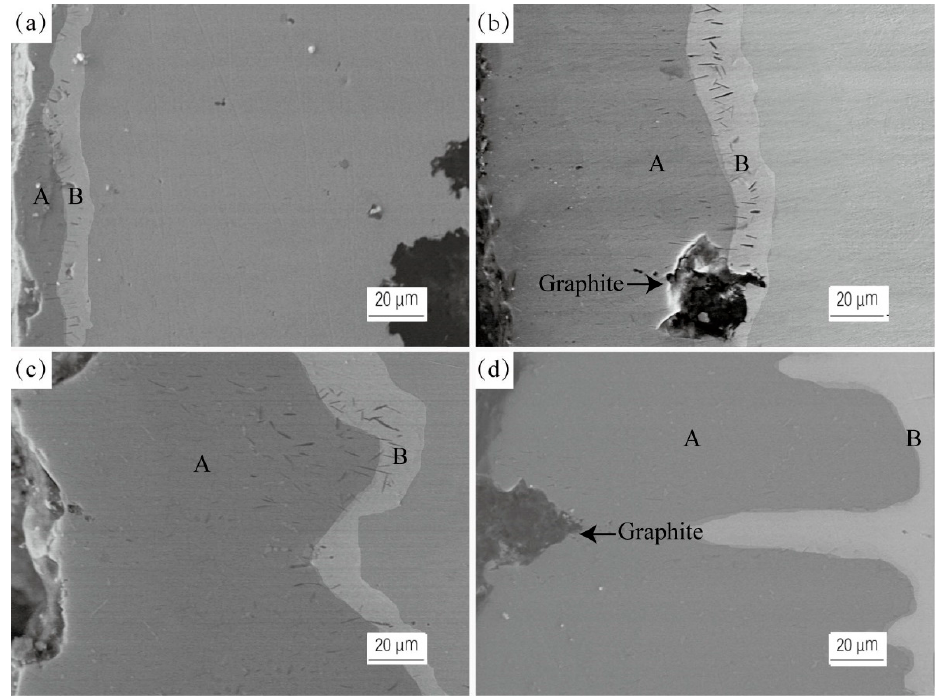
Figure 3. The cross-sectional microstructures of aluminizing samples at ( a ) 800 °C; ( b ) 830 °C; ( c ) 850 °C; ( d ) 880 °C.